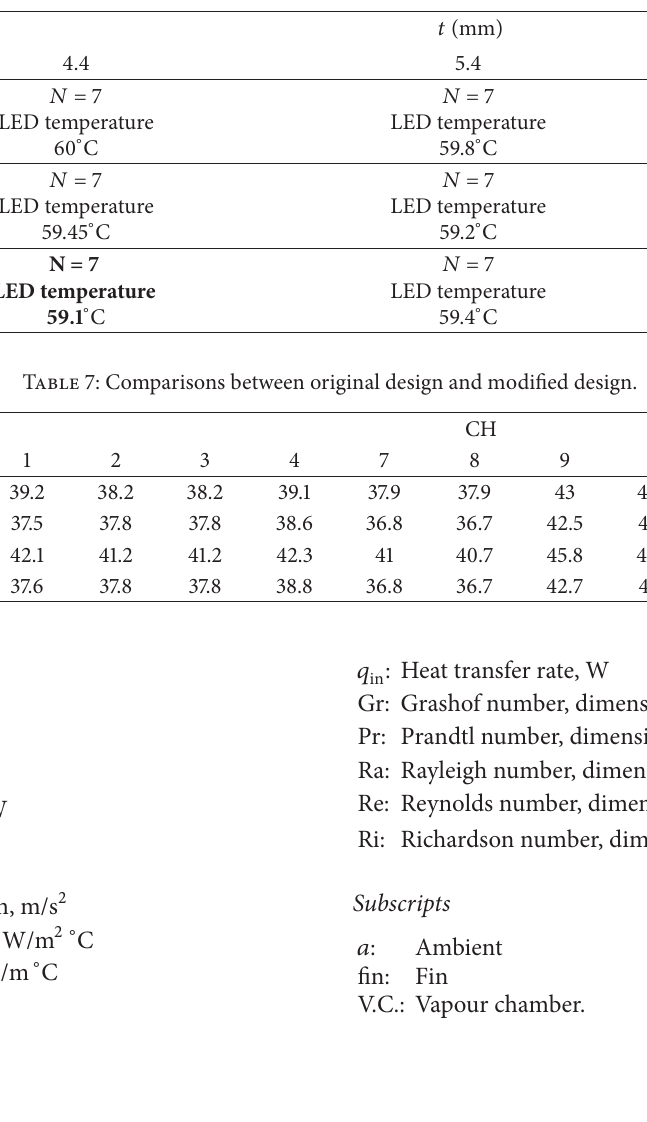
Table 6: Optimization fin geometry (3 × 3).